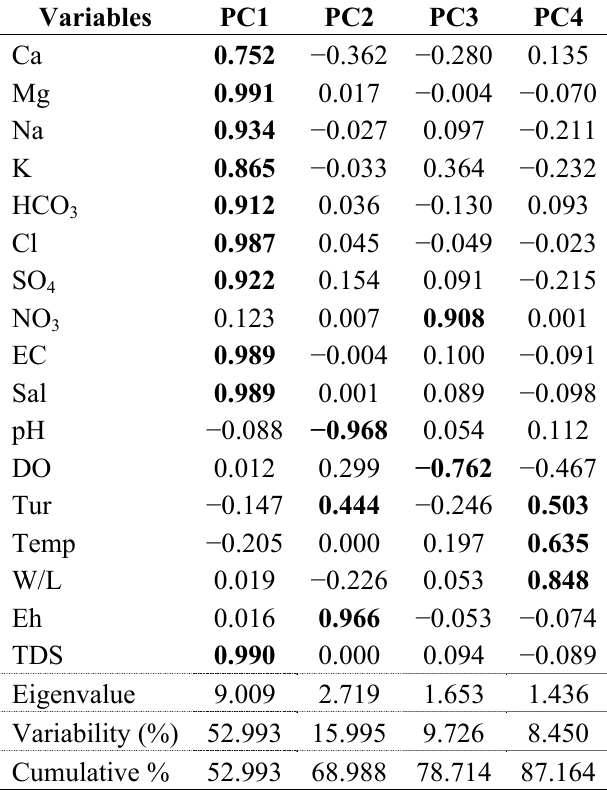
Table 5. Factor loadings after varimax